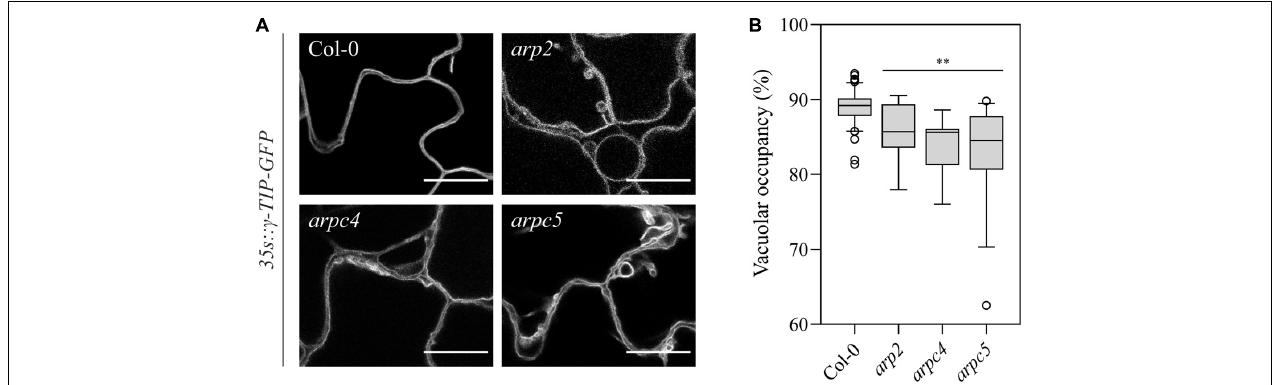
FIGURE 9 | (A) Observation of vacuolar organization in wild-type and arp2, arpc4 and arpc5 in 6DAG cotyledon expressing the γ TIP-mCherry marker (scale bar = 20 µ m). (B) Vacuolar occupancy quantifications at three-way cellular junctions. (Analysis performed in three biological replicates; Student’s t -test; ∗∗ p < 0.01; ∗ p <